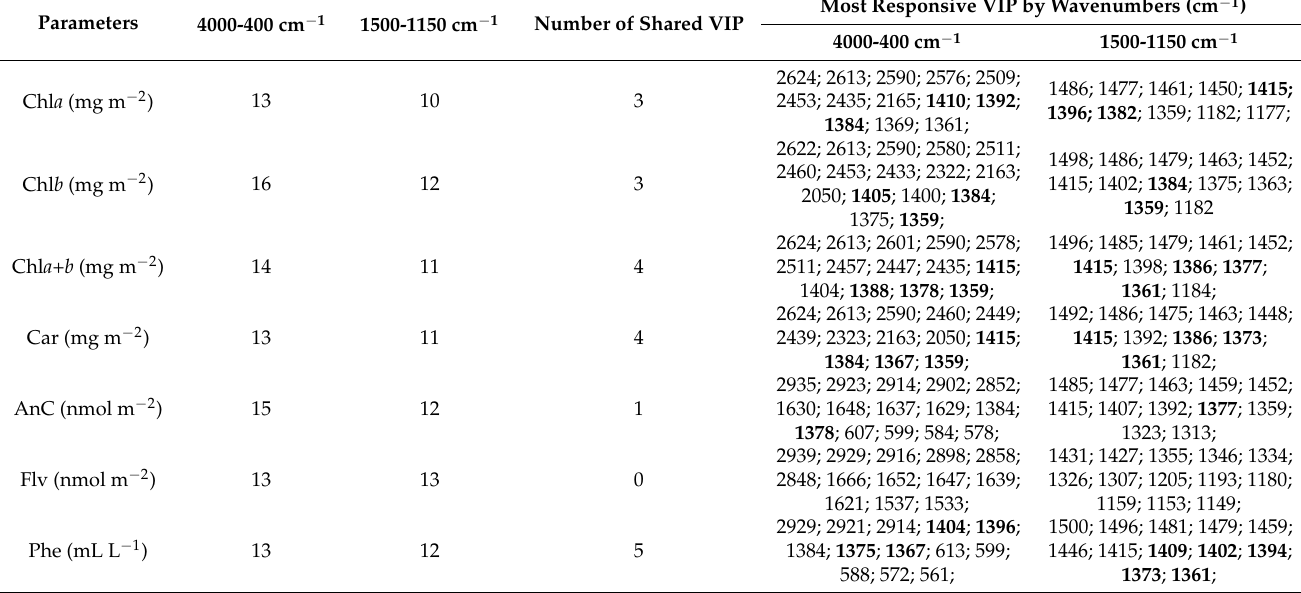
Table 4. The most responsive variable importance for projection (VIP) by wavenumbers selected between 4000 at 400 cm − 1 and 1500 at 1150 cm − 1 by ATR-FTIR spectroscopy according to the regres- sion β -coefficient for quality parameter for the PLSR model to predict. Parameter abbreviations—see Abbreviation list or Table 1.